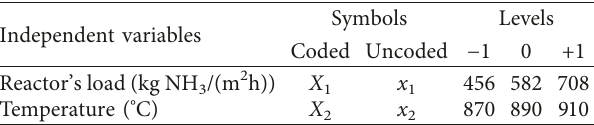
Table 2: Levels and actual values range of independent variables used in the conducted experiments.